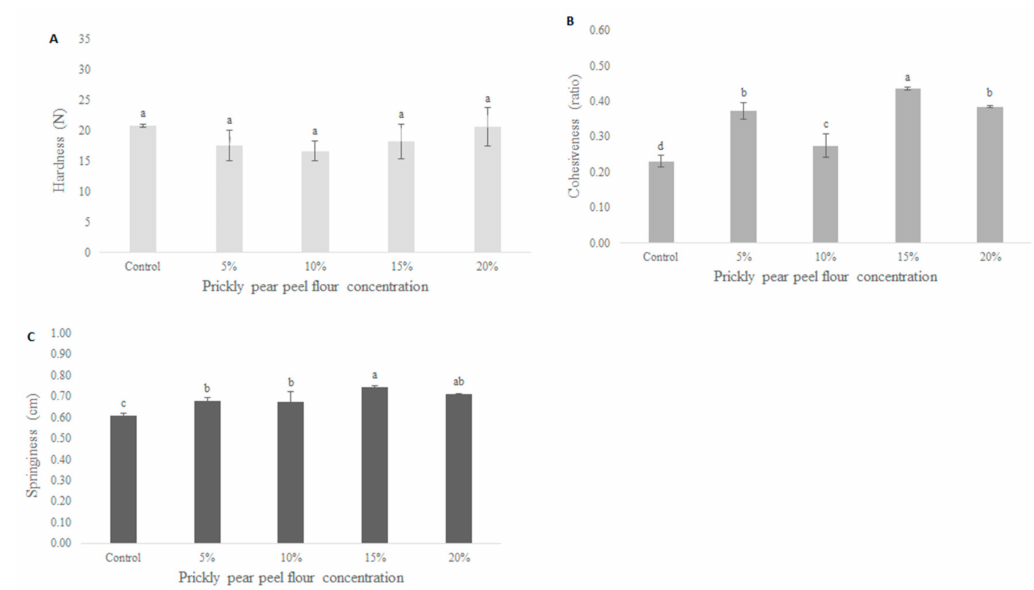
Figure 3. E ff ect of prickly pear peel flour concentration on the bread parameters: hardness ( A ), cohesiveness ( B ) and springiness ( C ). Columns followed by di ff erent letters are significantly di ff erent according to Fisher’s least significant di ff erence test ( p < 0.05). Vertical bars indicate the standard deviation of the